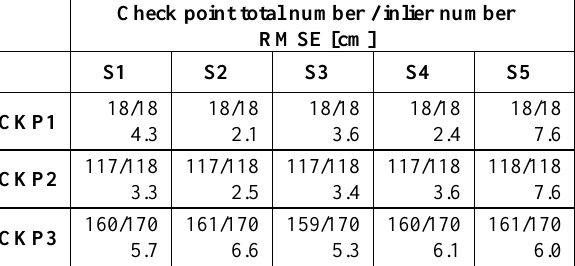
Table 8. Accuracy assessment for the five scenarios considered and for the three check point sets